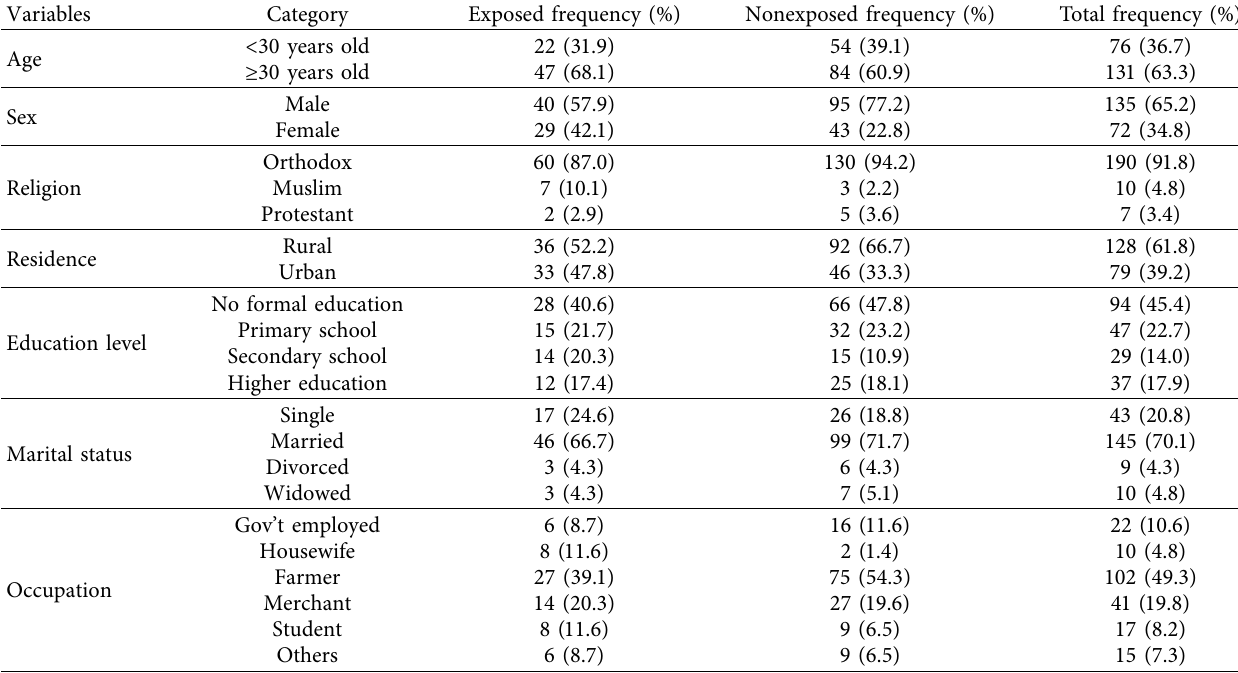
Table 1: Socio-demographic characteristics of patients with fracture in DMCSH, 2021.